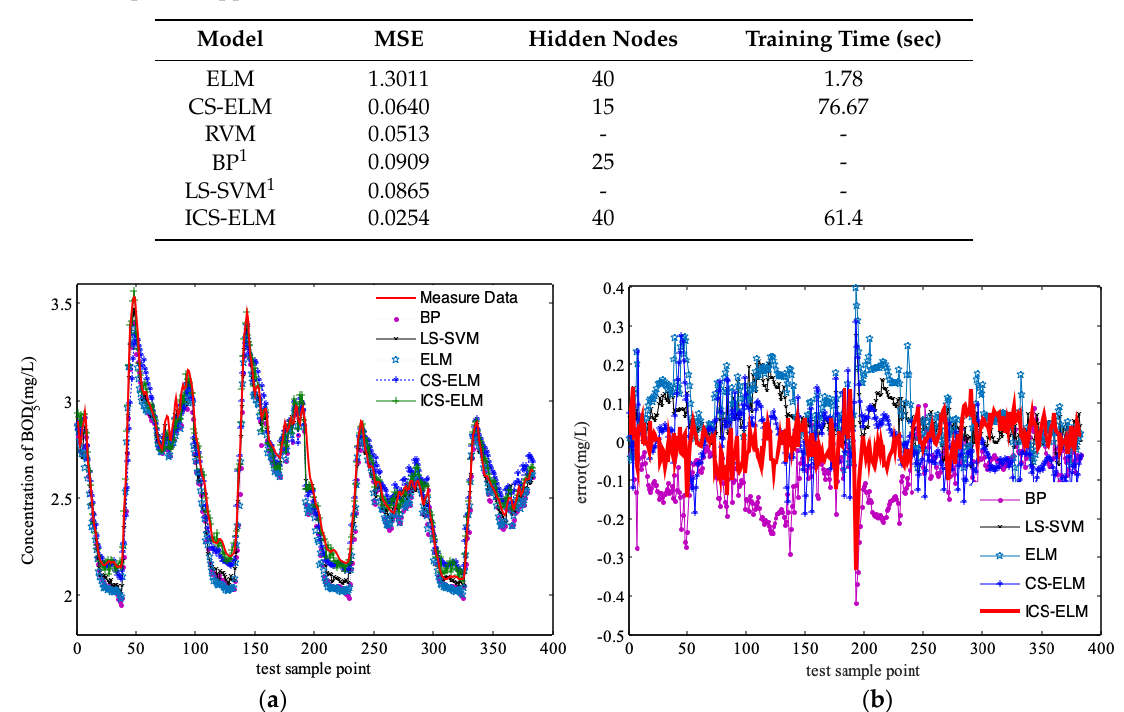
Table 3. Prediction results of the six soft sensor models. MSE: mean square error; CS-ELM: cuckoo search-extreme learning machine; RVM: relevance vector machine; BP: back propagation; LS-SVM: least squares support vector machines.